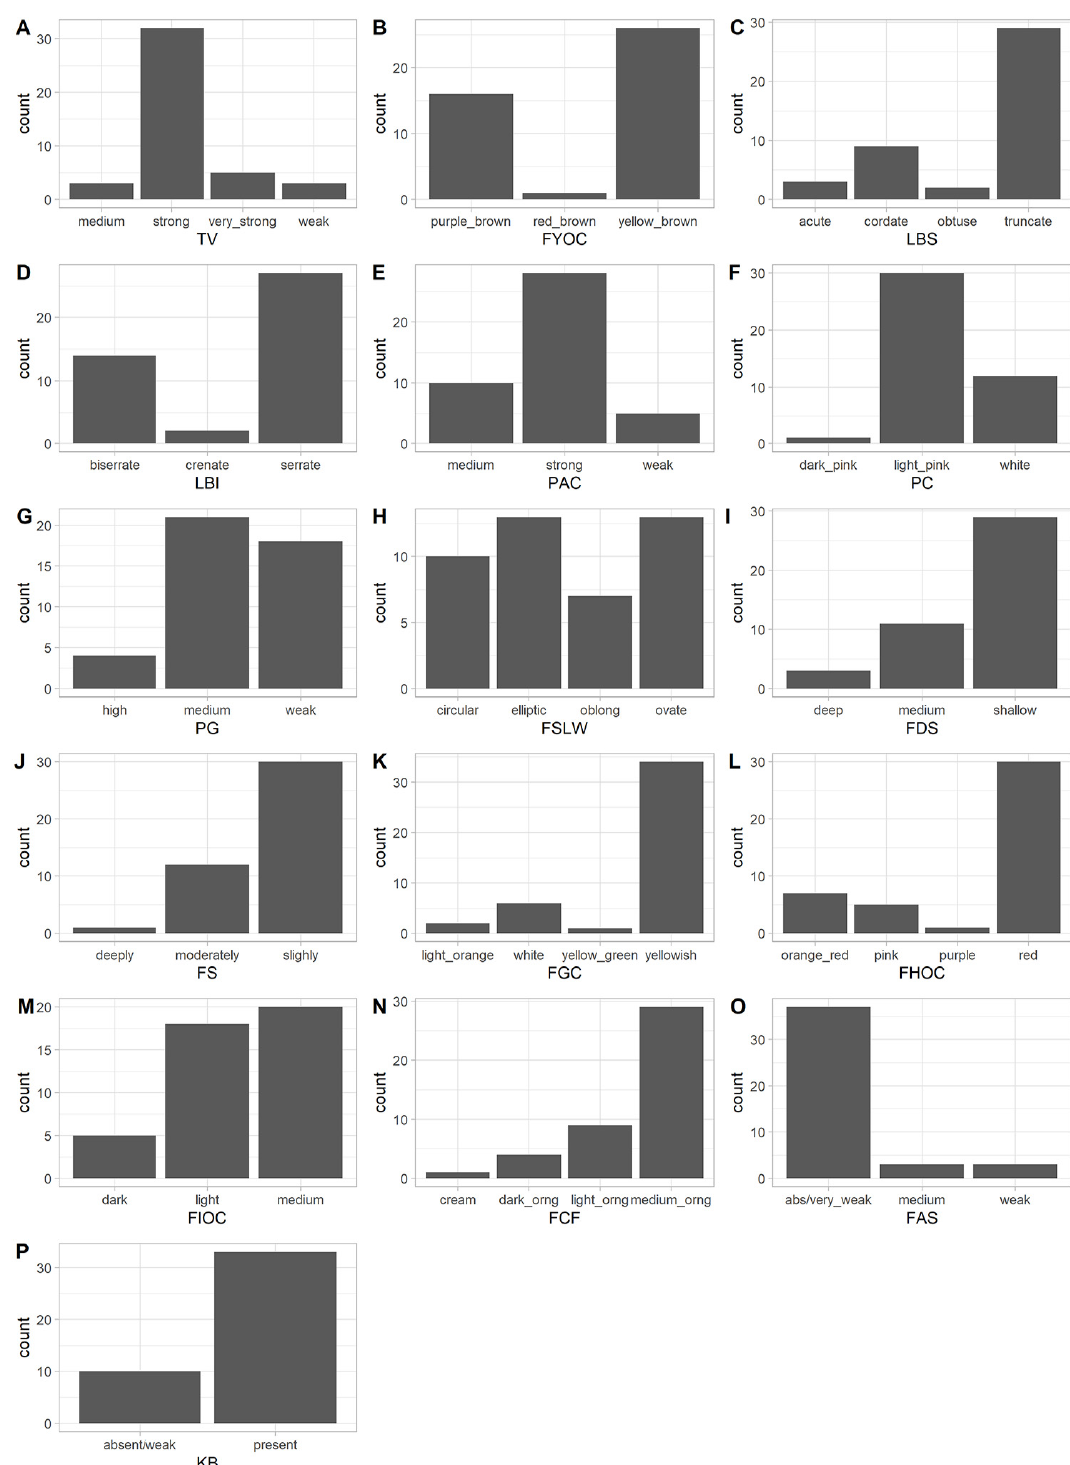
Figure 1. Distribution of the phenotypes for the 16 qualitative traits in the apricot population. ( A ) TV: tree vigor; ( B ) FYOC: one-year-old shoot color on sunny side; ( C ) LBS: leaf blade shape of base; ( D ) LBI: leaf blade incisions of margin; ( E ) PAC: petiole anthocyanin coloration of upper side; ( F ) PC: petal color on lower side; ( G ) PG: pollen germinability; ( H ) FSLW: fruit shape in lateral view; ( I ) FDS: fruit depth of stalk cavity; ( J ) FS: fruit suture; ( K ) FGC: fruit ground color of skin; ( L ) FHOV: fruit hue of over color; ( M ) FIOC: fruit intensity of over color; ( N ) FCF: fruit color of the flesh; ( O ) FAS: fruit adherence of stone to flesh; ( P ) KB: kernel